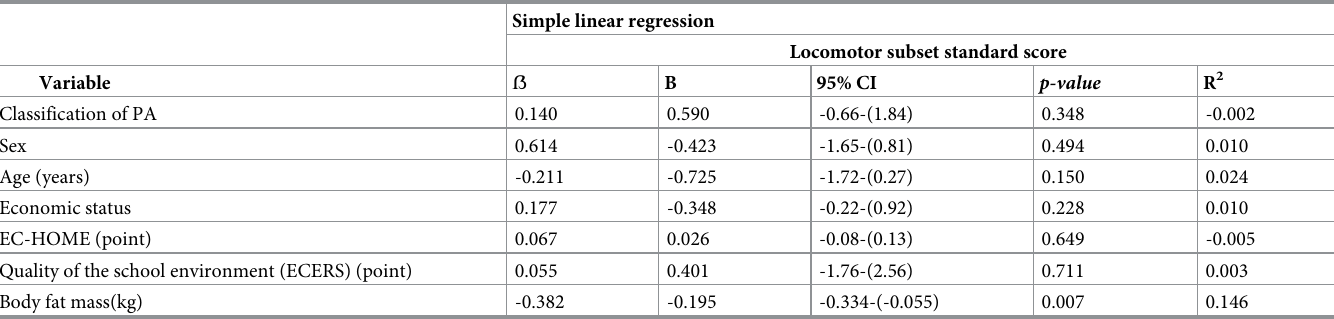
Table 3. Regression between independent variables and standard locomotor score. (N = 48).